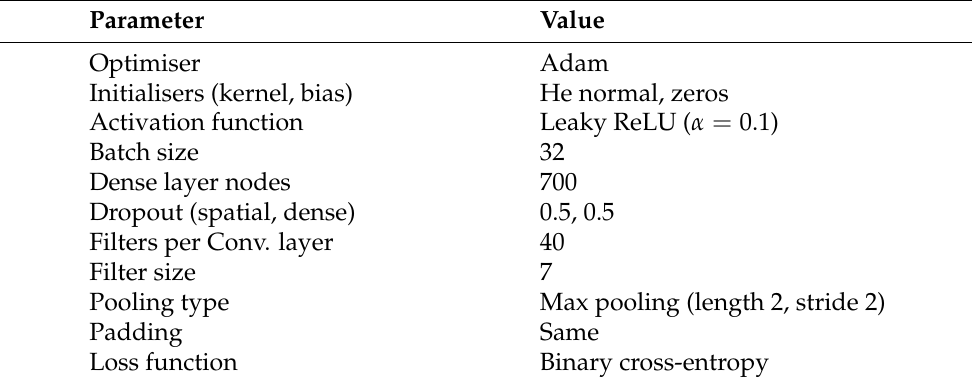
Table 2. Relevant reference model